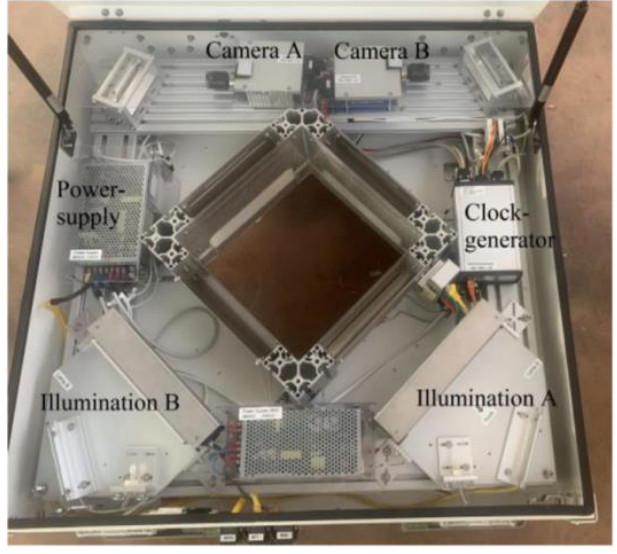
Figure 4. 2DVD system used to measure the characteristics of rainfall drops.